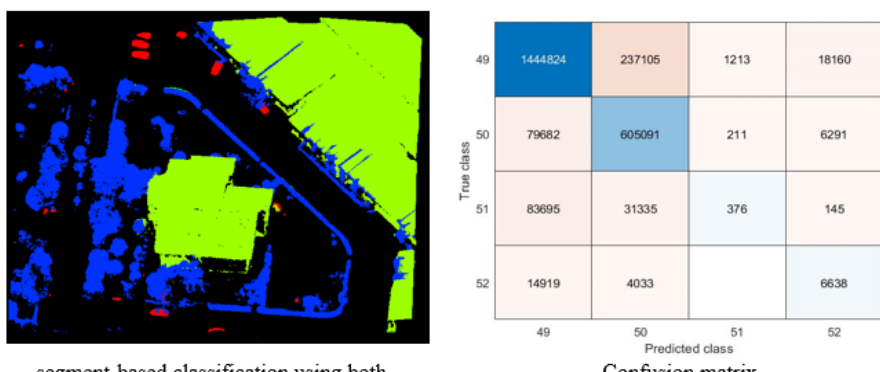
Figure 7. Classification results based different conditions